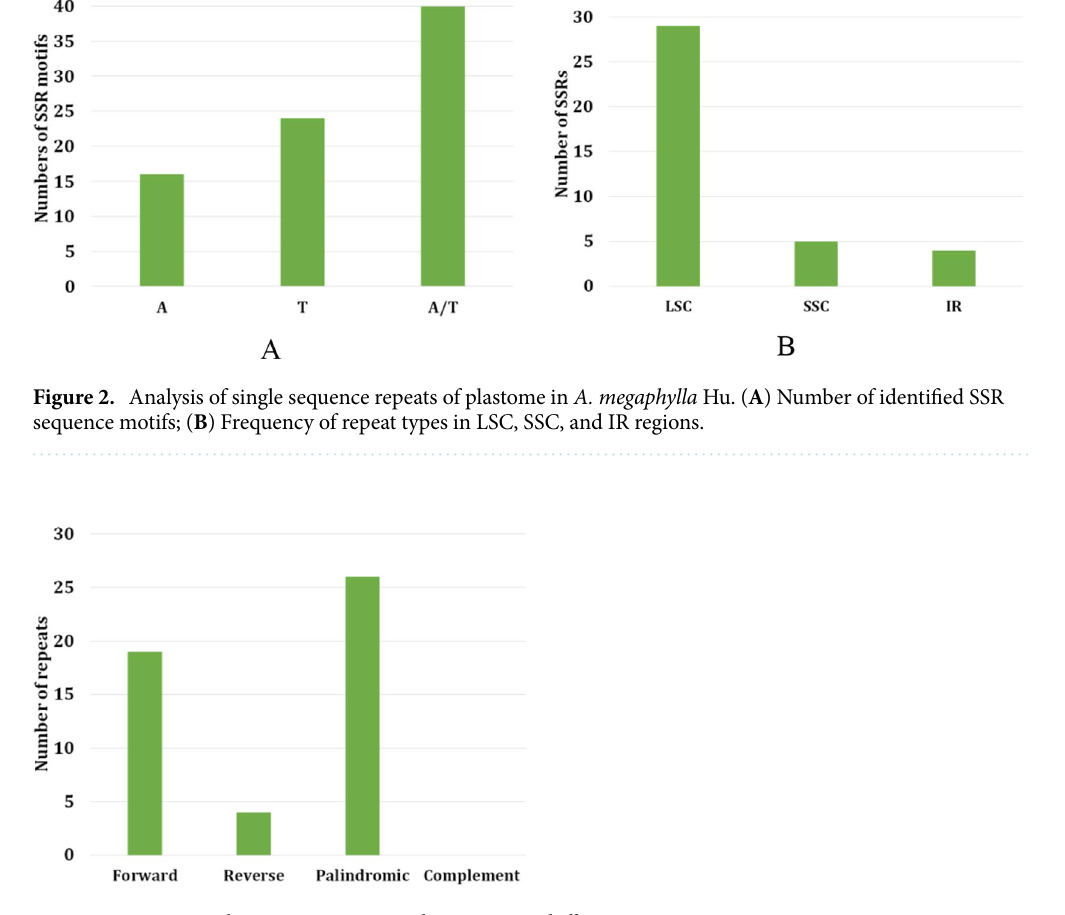
Figure 3. Repeat analysis on a genomic scale in A. megaphylla